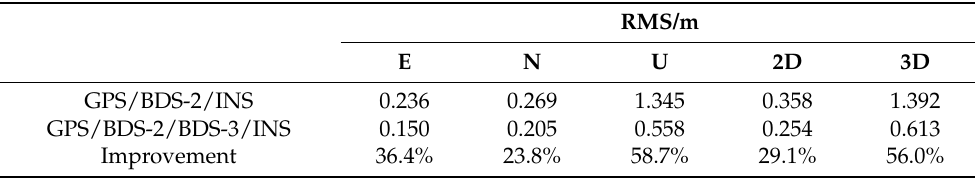
Figure 10. The GNSS/INS tightly coupled positioning results of different satellite systems and INS: ( a ) GPS/BDS-2/INS; ( b ) GPS/BDS-2/BDS-3/INS. Table 8. Positioning error statistics of the GNSS/INS tightly coupled with or without